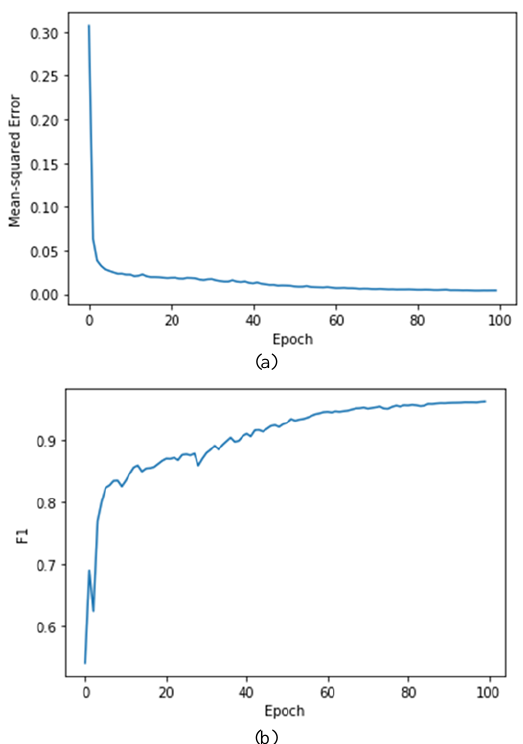
Fig. 6 (a) Huber loss vs epoch, (b) Training F1 vs epoch using Huber loss Table 1. Training result